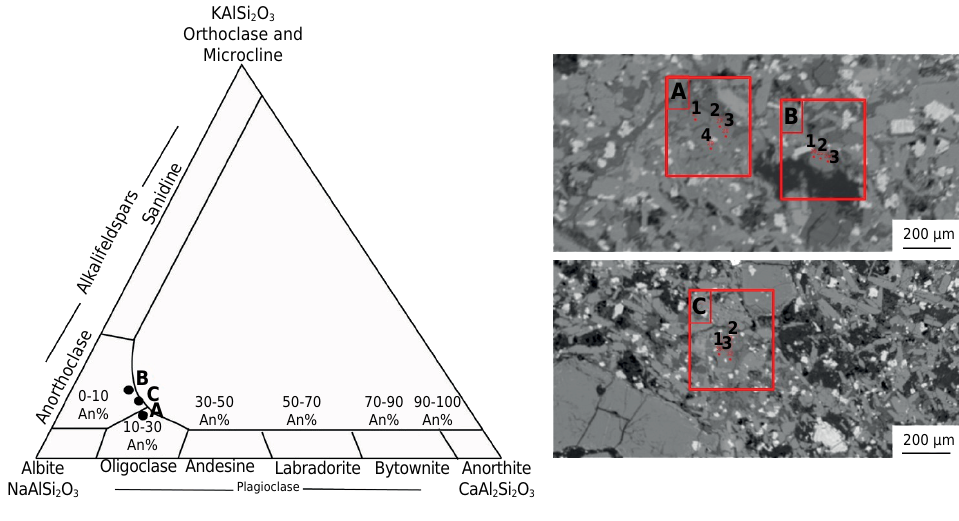
Figure 4. Feldspar diagram and SEM images of the C2 horizon. The plot of microchemical analyses in the diagram shows that the crystal A is an oligoclase and, B and C are anorthoclase.